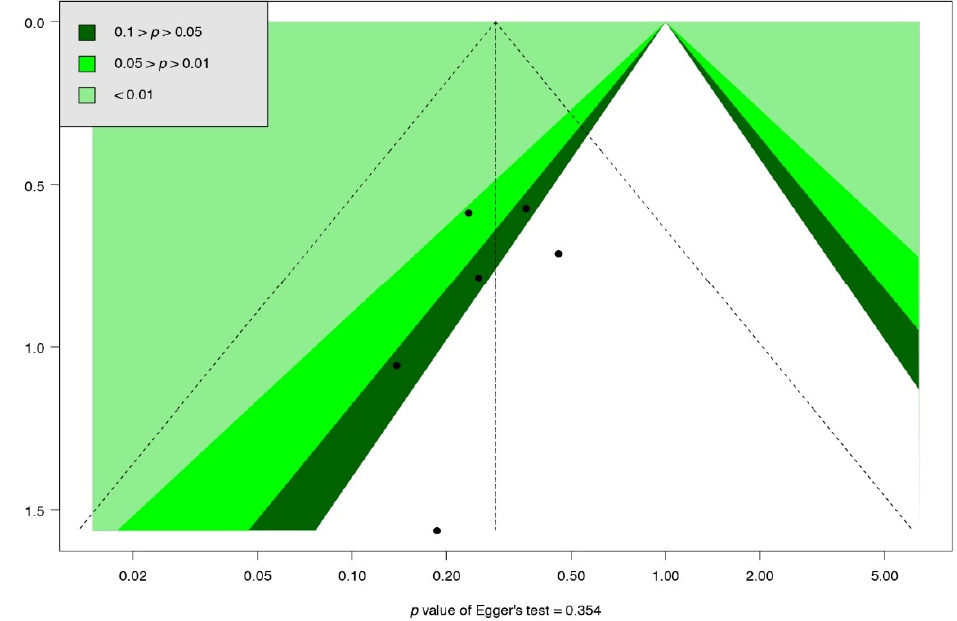
Figure A40. Comparison-adjusted funnel plot in outcome for severe complications.